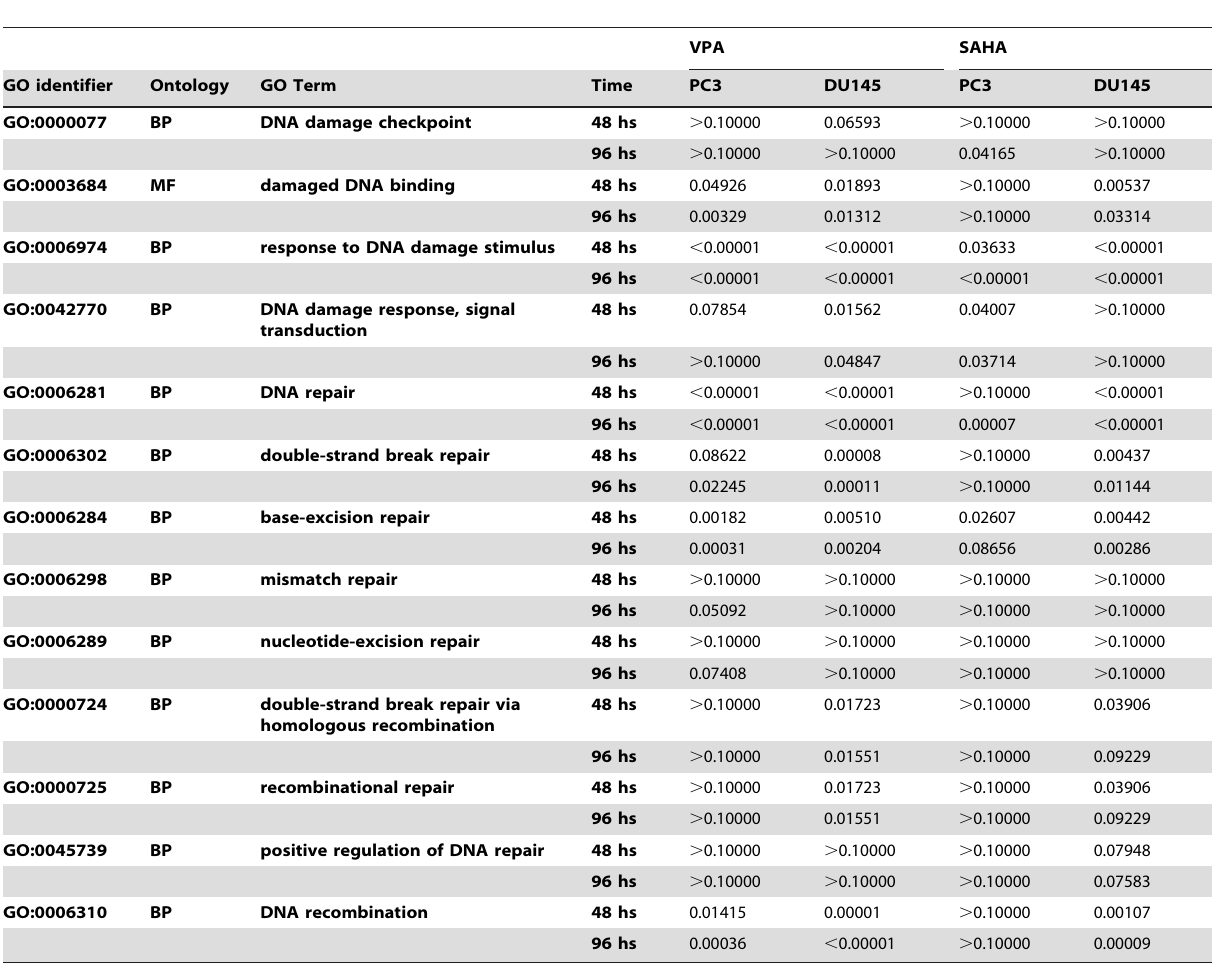
Table 1. Analysis of Functional Annotation results for gene ontology.